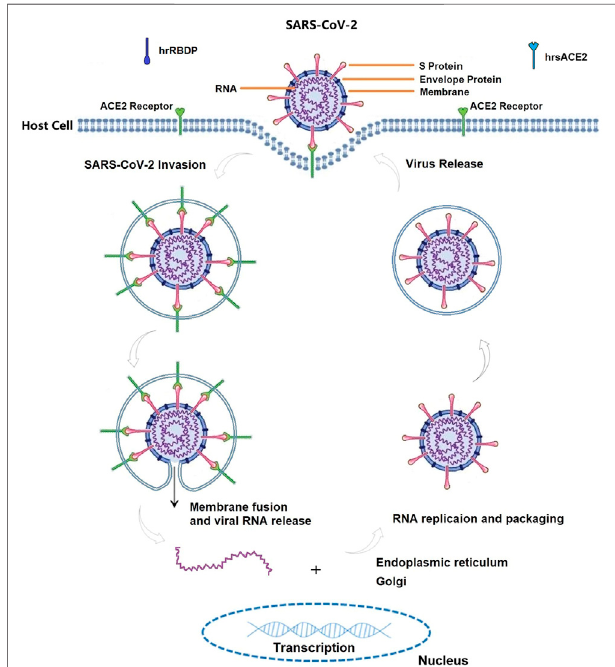
FIGURE 3 | The life cycle of SARS-CoV-2 in host cells, annotated with the known mechanisms by ACE2 biology pathway. ACE2 can be recognized by the spike (S) protein on the surface of SARS-CoV-2, and their combination enable the virus to enter human cells in term of attachment, fusion and entry. S protein compose of S1 subunit (containing receptor-binding domain (RBD) which can bind to host receptor) and S2 subunit (fusing the viral and host membranes). Therefore, both ACE2 and S protein can serve as targets for the development of entry inhibitors, antibodies, and vaccines. Any substances modifying ACE2-S protein complex are valid targets for anti- COVID-19 agents. For instances, human recombinant soluble ACE2 (hrsACE2, its structure similar with ACE2) and recombinant RBD protein (hrRBDP, its structure similar with S protein) are competitively binding to S protein and ACE2 receptor, which ultimately participate in the fi ght against